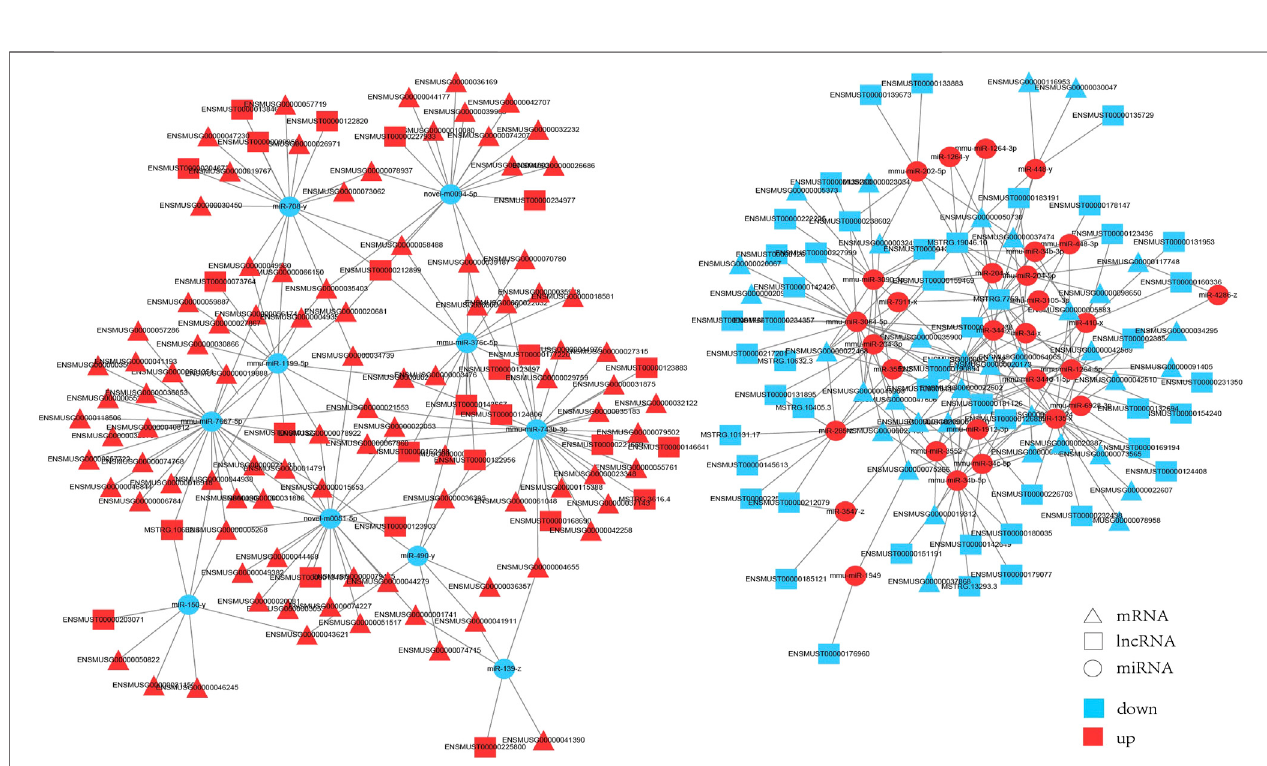
FIGURE 6 | The interaction network of lncRNA-miRNA-mRNA. Triangle represents mRNAs, square represents lncRNAs, circle represents miRNAs. Red: upregulation; blue: downregulation.